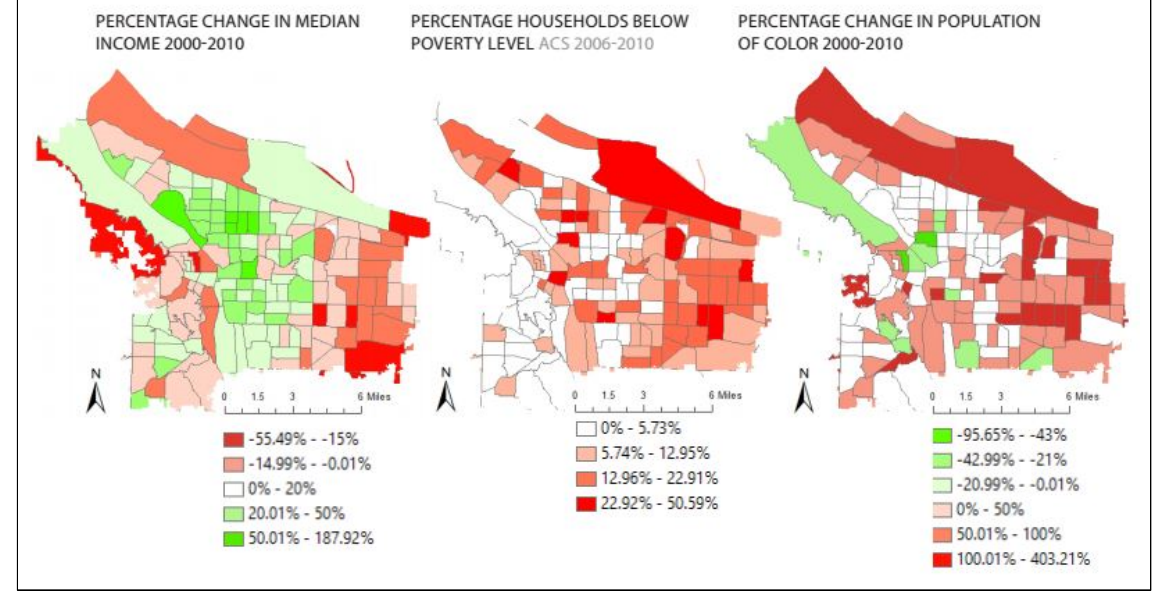
Figure 5. Maps Showing Indicators of Gentrification-Driven Displacement in